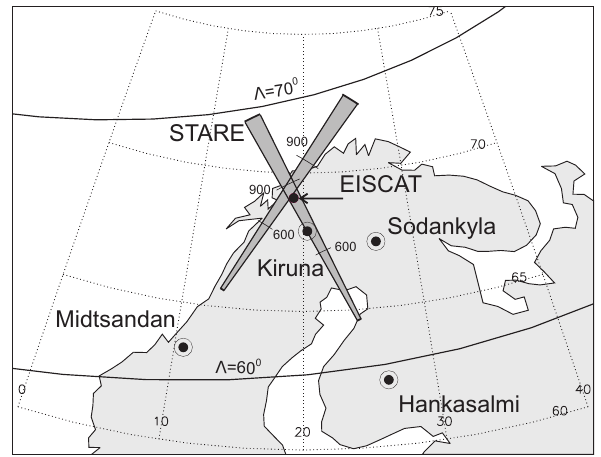
Figure 1: Uspensky et Fig. 1. Field of view of the Hankasalmi Finland STARE radar beam 3 and the Midtsandan Norway STARE radar beam 4, assuming 110- km height of scatter. Lines across the beams are slant range marks of 600 and 900km. Solid dot denotes the area where ionospheric parameters were measured by the EISCAT incoherent scatter fa- cility, which includes UHF transmitter/receiver in Tromso and re- ceivers in Kiruna and Sodankyla. The solid thick lines represent the PACE magnetic